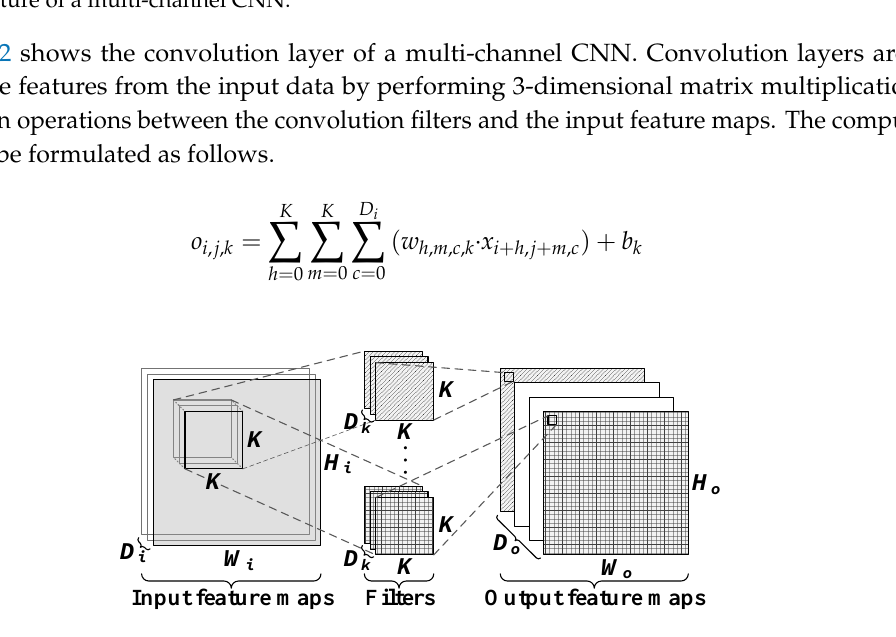
Figure 2. Convolution layer of a multi-channel CNN.